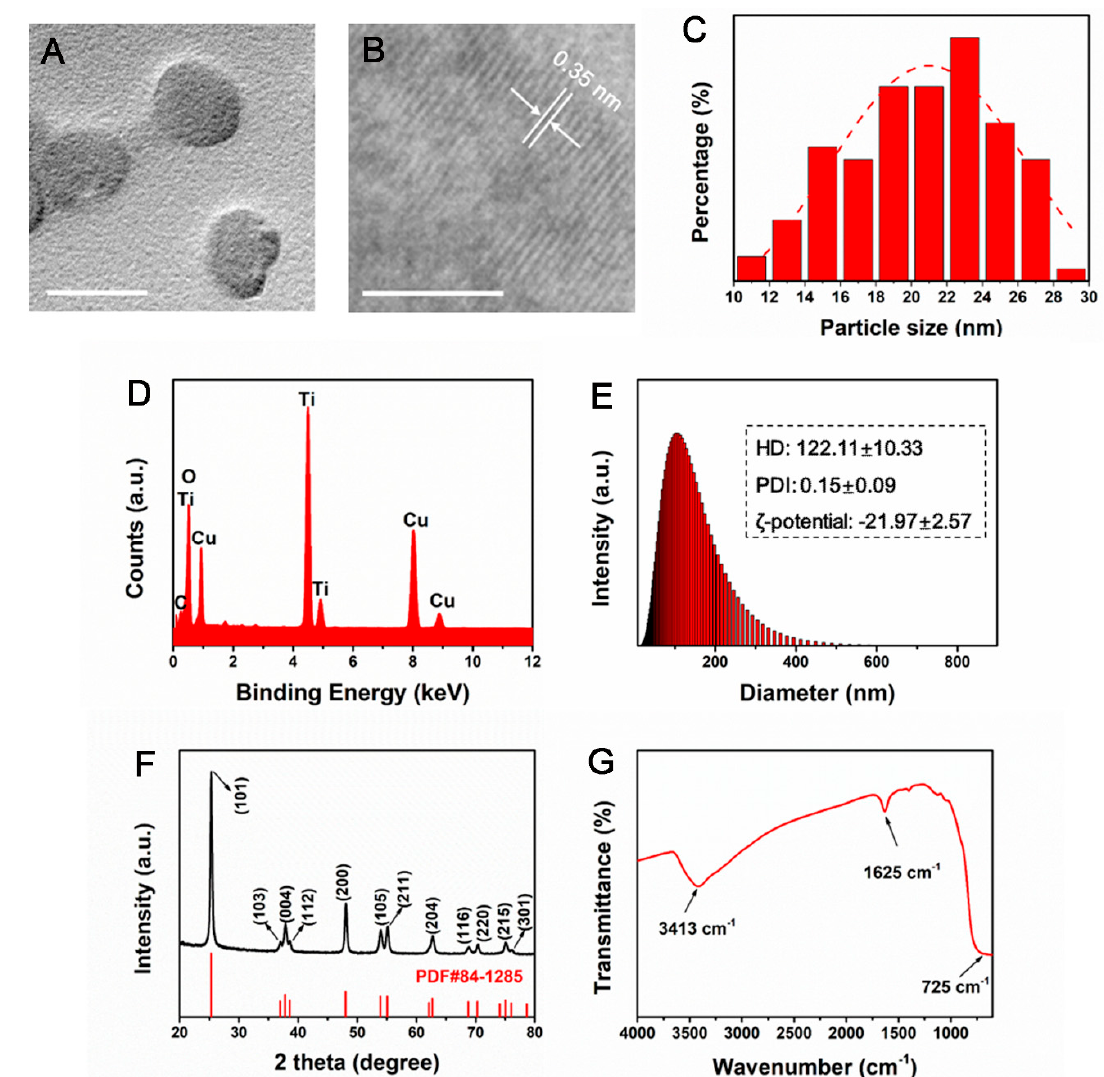
Figure 1. Physicochemical characterization of TiO 2 NPs. ( A ) The representative TEM image (scale bar: 20 nm). ( B ) HRTEM image (scale bar: 5 nm). ( C ) Particle size distribution of TiO 2 NPs. ( D ) Energy dispersive spectroscopy (EDS). ( E ) DLS measurements showing size distribution, HD, PDI and zeta potential. ( F ) Diffraction pattern showing crystalline structure. ( G ) FT-IR.